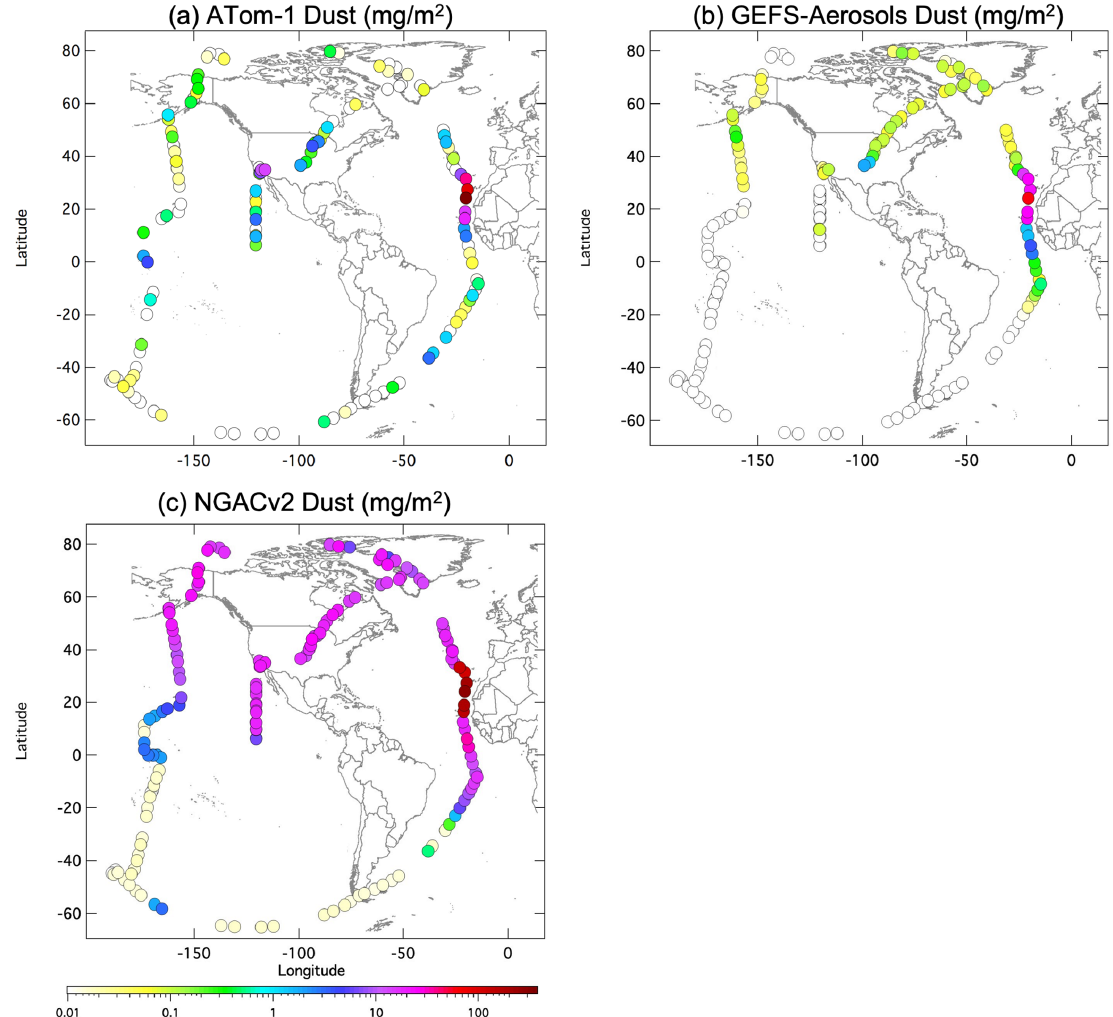
Figure 15. Tropospheric column sums of dust ( < 3.0µm diameter) for (a) ATom-1 DC-8 observations, (b) GEFS-Aerosols, and (c) NGACv2.